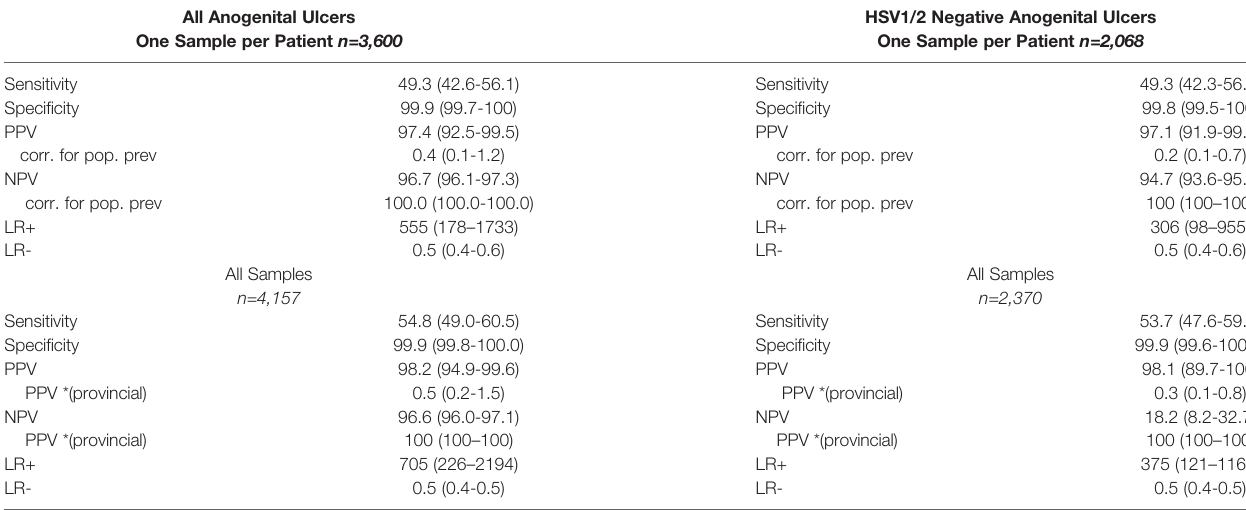
TABLE 2 | Test Characteristics for Tp -PCR among unique patients and independent patient cases with expert clinical suspicion of primary syphilis for all anogenital ulcers sampled and HSV1/2 negative anogenital ulcers sampled. All Anogenital